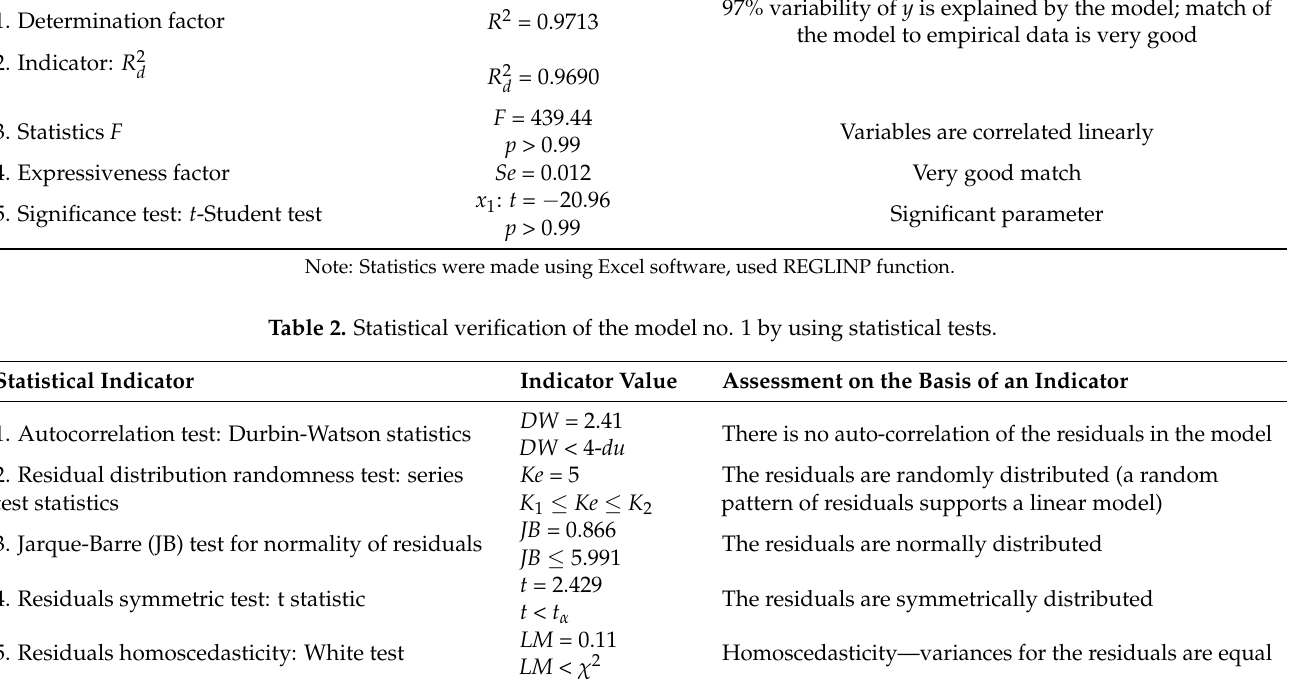
Table 1. Basic statistical analysis of the model no. 1.